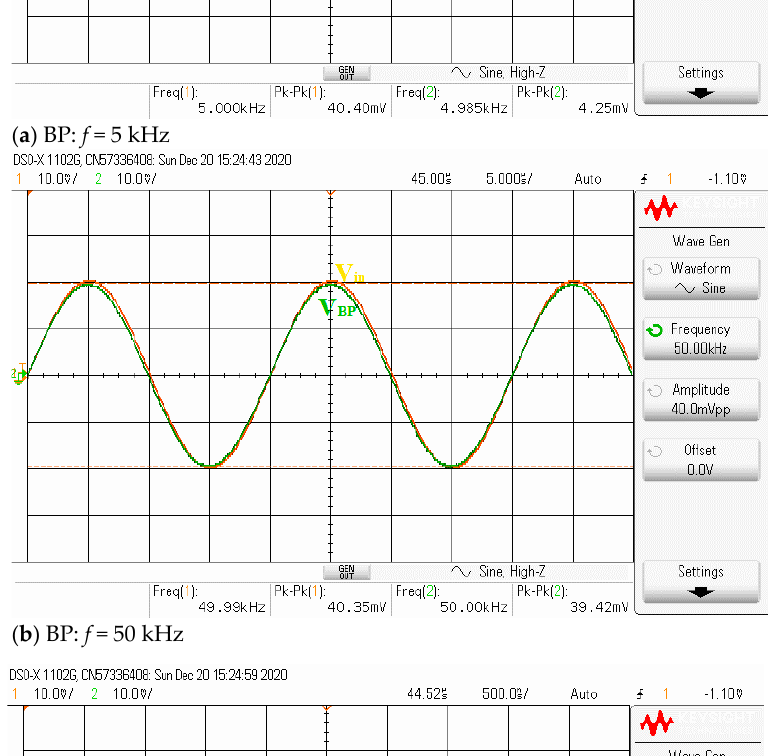
Figure 22. Experimental BP responses for different I B1 values ( I B2 = 195 µA, R 1 = 1 k Ω and C 1 = C 2 = 5.5 nF).